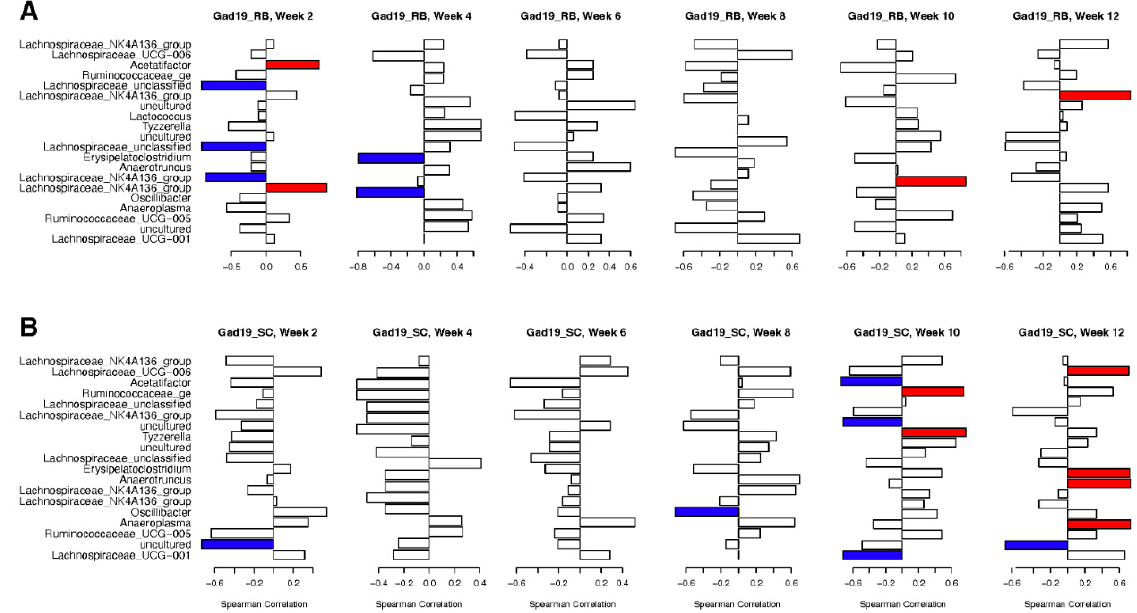
Figure 8. Spearman’s correlation plots between the 20 most impactful taxa from the whole microbiome and MPER-specific IgA production in the fecal samples. Positive correlations are represented in red and negative correlations in blue. No correction for multiple testing was applied, and significance was set to <0.1.